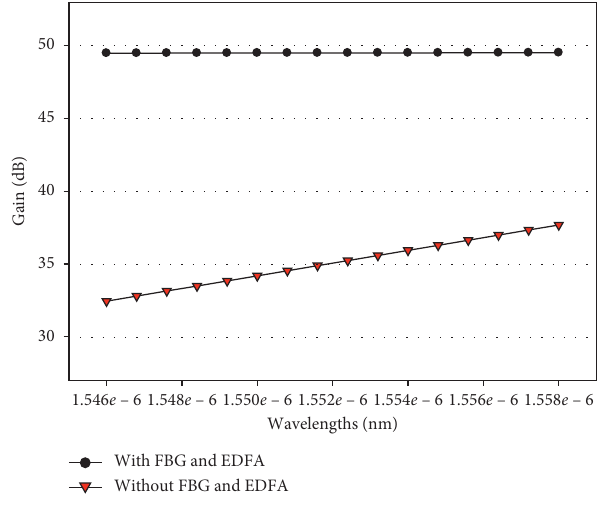
figure optimization of C -band EDFA in 16-channels WDM